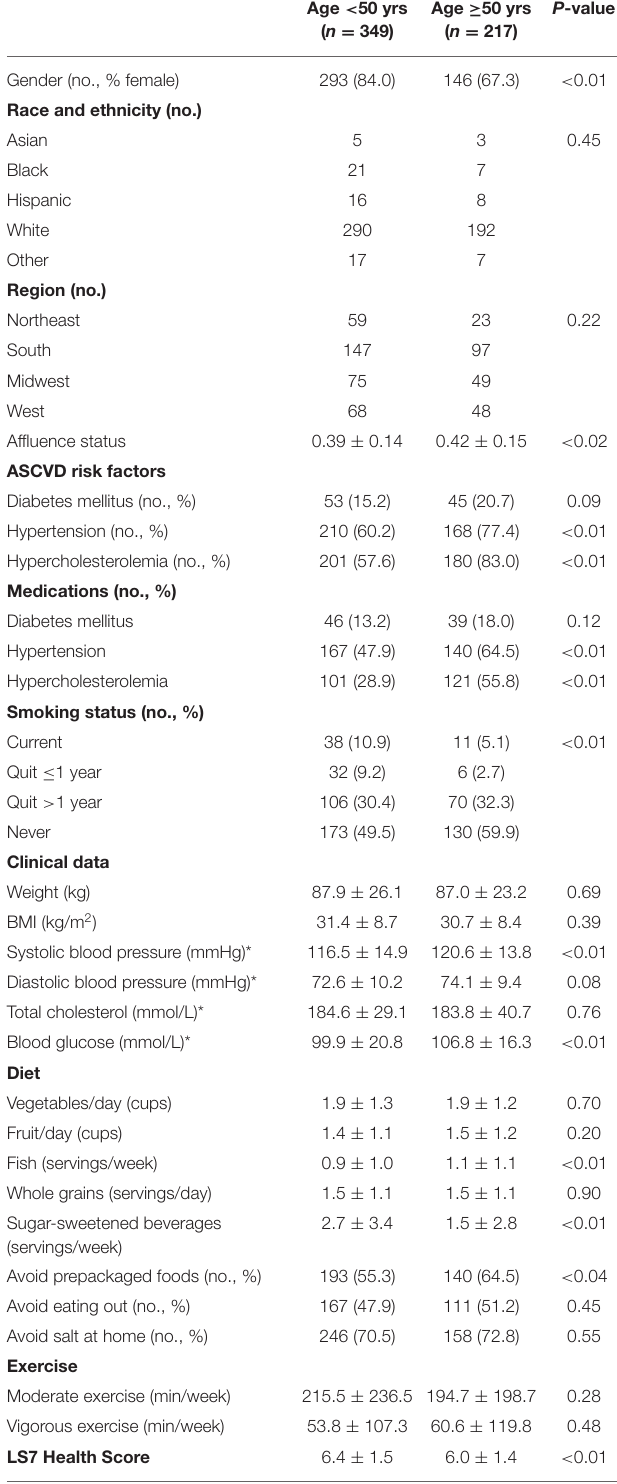
TABLE 2 | Life’s Simple 7 data for participants age < 50 and ≥ 50 yrs with